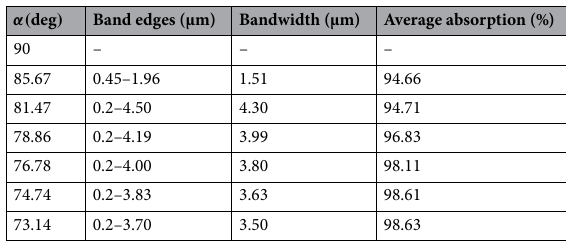
Table 1. Absorption band for absorption >90 % versus different side angles of the cone in the range of 0.2–0.45 µm.